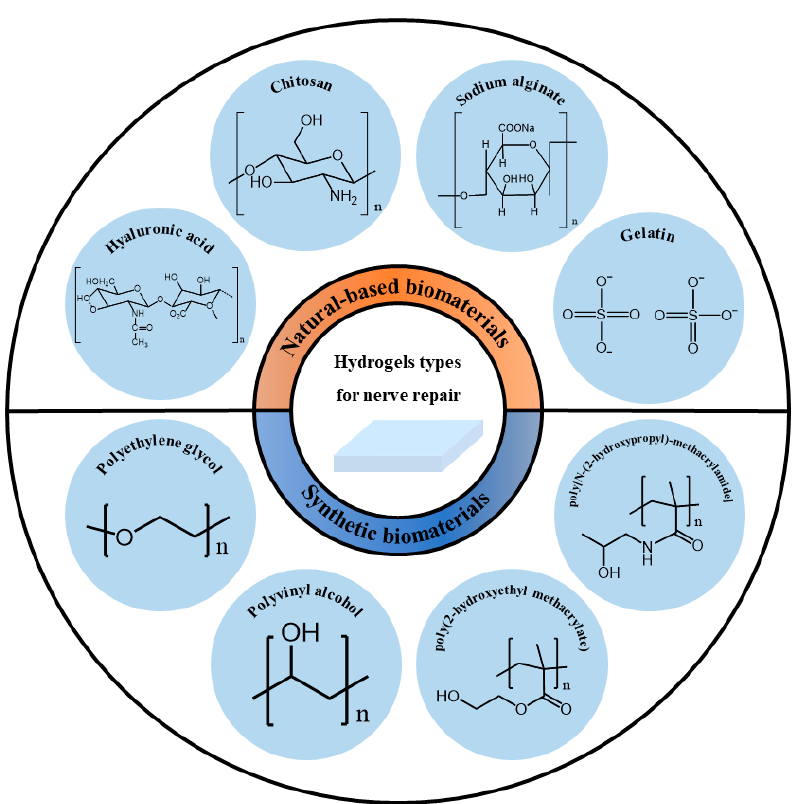
Figure 2. Classification of hydrogel carriers for nerve repair based on their sources.